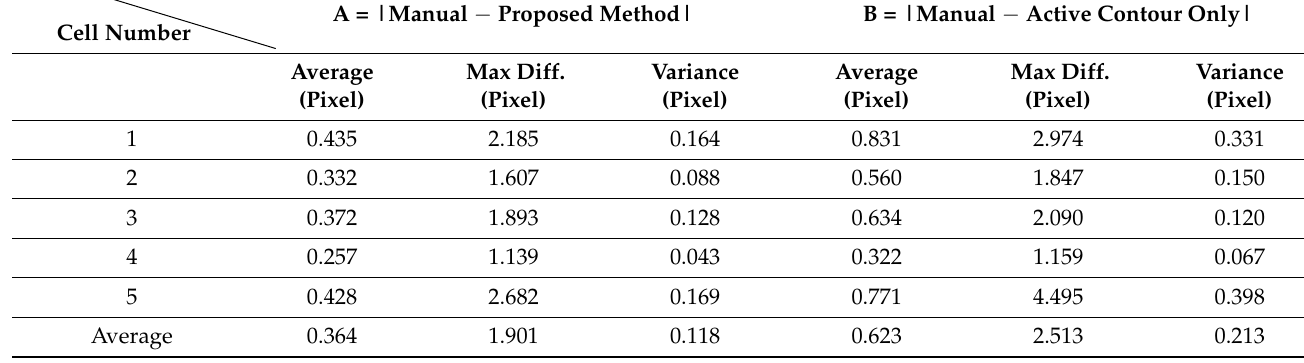
Table 1. Comparison of the proposed work and without background